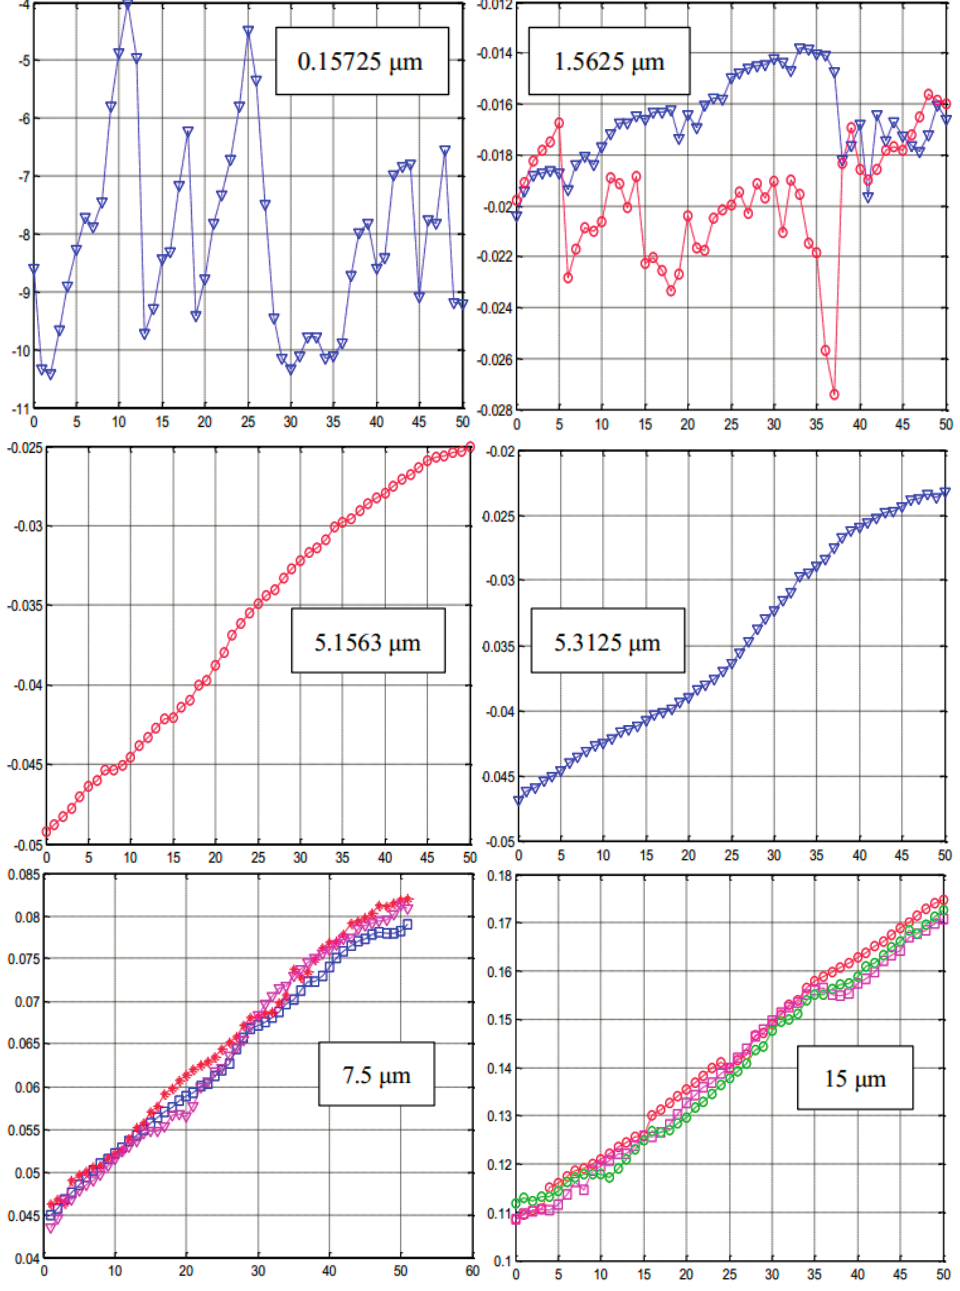
Figure 9. The characteristic curves of the